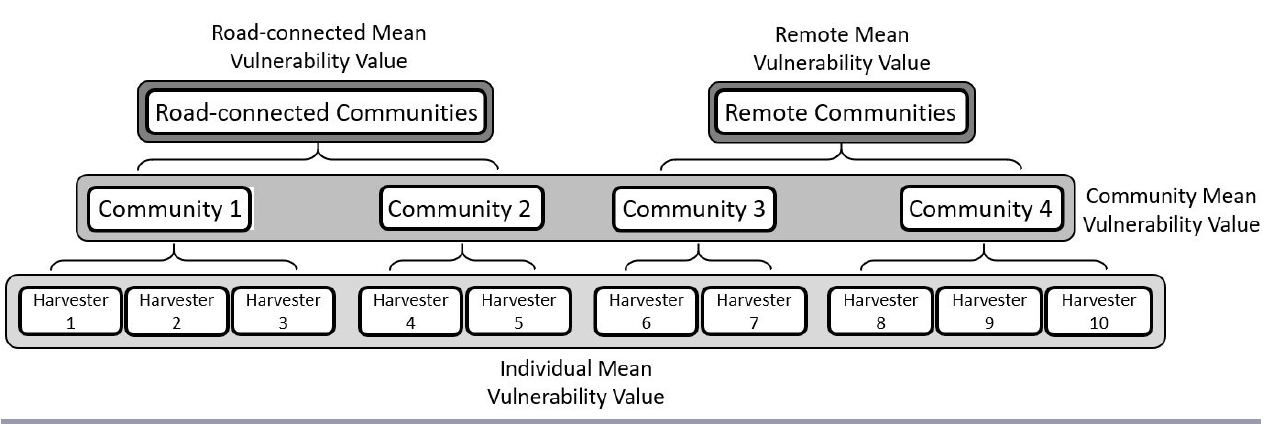
Fig. 3 . Visual example of data groupings used for different analyses. Mean vulnerability values for each environmental condition were averaged to create an overall vulnerability value for individuals, for all communities combined, for road-connected communities combined, and for remote communities combined.